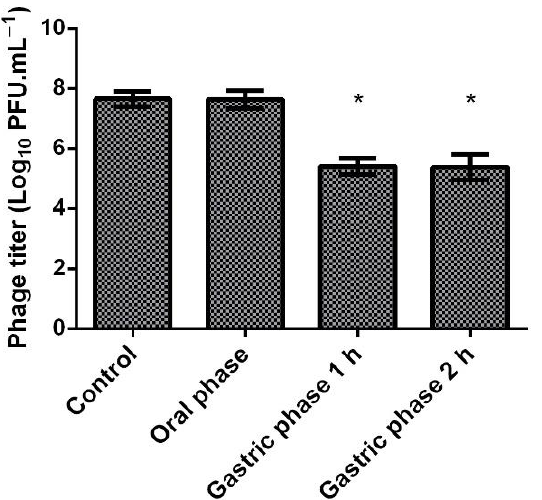
Figure 4. Stability of the HPy1R after the in vitro digestion. Error bars represent standard deviations for three independent assays ( n = 3) performed in duplicate. * Statistical differences compared with the control ( p < 0.05).